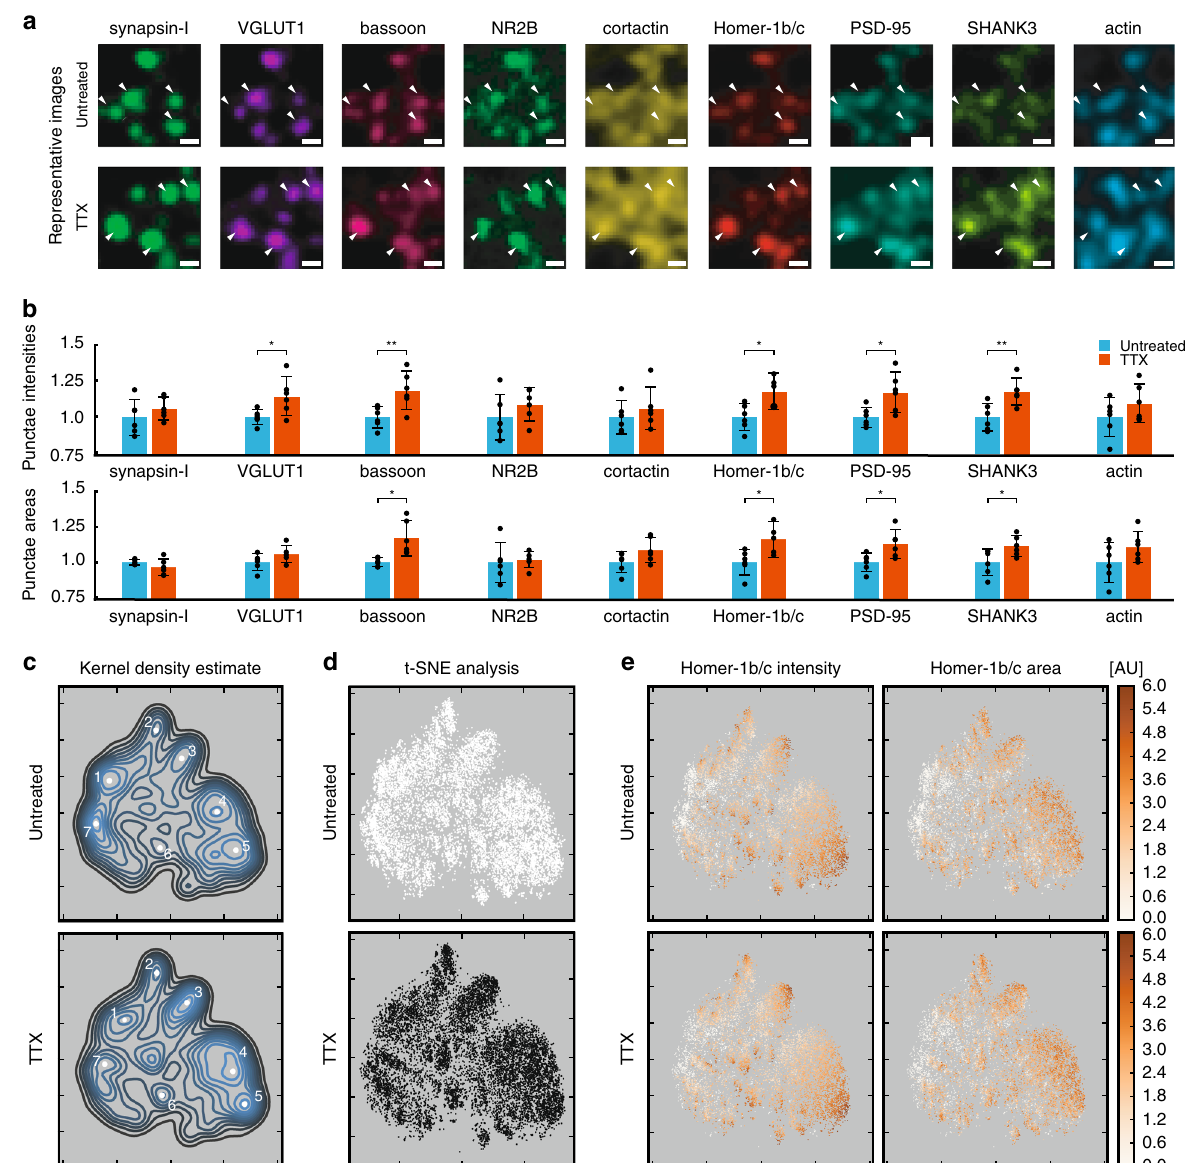
Fig. 5 Analysis of synaptic remodeling from confocal imaging. a Representative images of synapses from 21 days in vitro rat hippocampal neurons. White arrowheads indicate synapses. Scale bar: 1 μ m. b Bar heights indicate the average synaptic integrated intensities (top) or average synaptic punctae areas (bottom) of untreated and TTX treated neurons relative to the mean of the untreated group. Error bars represent 95% con fi dence intervals. P -values are computed using Student ’ s t -test with n = 6 replicates; p < 0.05 (*), p < 0.01 (***). c – e t-SNE plots of individual synapses from untreated ( n = 10,000) and TTX treated ( n = 10,000) synapses. Mean intensities and areas from each target are used as input. c Kernel density estimate of t-SNE output. White points indicate potential synaptic sub-types. d Individual points color-coded to indicate untreated (white) or TTX treated (black) synapses. e Individual points are color-coded for Homer-1b/c mean intensity and Homer-1b/c imaging of neuronal synapses also corresponded well with the resolution DNA-PRISM images of microtubules and actin in wide fi eld IF images, but with signi fi cantly improved resolution, as neurons were fi rst compared with wide fi eld IF images. Super- expected, revealing closely apposed pre- and post-synaptic sites resolved microtubules formed bundles within neuronal processes, (Fig. 6e – f). We quanti fi ed the average synapse size de fi ned by whereas actin exhibited linear, fi lamentous structures within these synapsin-I and PSD-95 punctae using the radial cross-correlation regions, but showed punctate structures within dendritic spines function between synapsin-I and PSD-95, with the decay length (Fig. 6a – d). Subcellular structures imaged with DNA-PRISM of the correlation function revealing an average synapse size of correlated well with the corresponding wide fi eld images, but with ~200 nm (Fig. 6i) 12 . The spatial decay of the DNA-PRISM cor- signi fi cantly improved spatial resolution (Fig. 6b, d). A Gaussian fi t to the cross-sectional pro fi le of a single microtubule produced relation curve occurred at a smaller spatial scale than the wide- fi eld imaging curve, indicating the smaller synapse size revealed a full-width at half-maximum (FWHM) of 46.5 nm (Fig. 6g), by DNA-PRISM due to enhanced resolution relative to wide fi eld which is consistent with previous PAINT measurements in HeLa imaging. cells 21 . In addition to microtubules and actin, DNA-PRISM